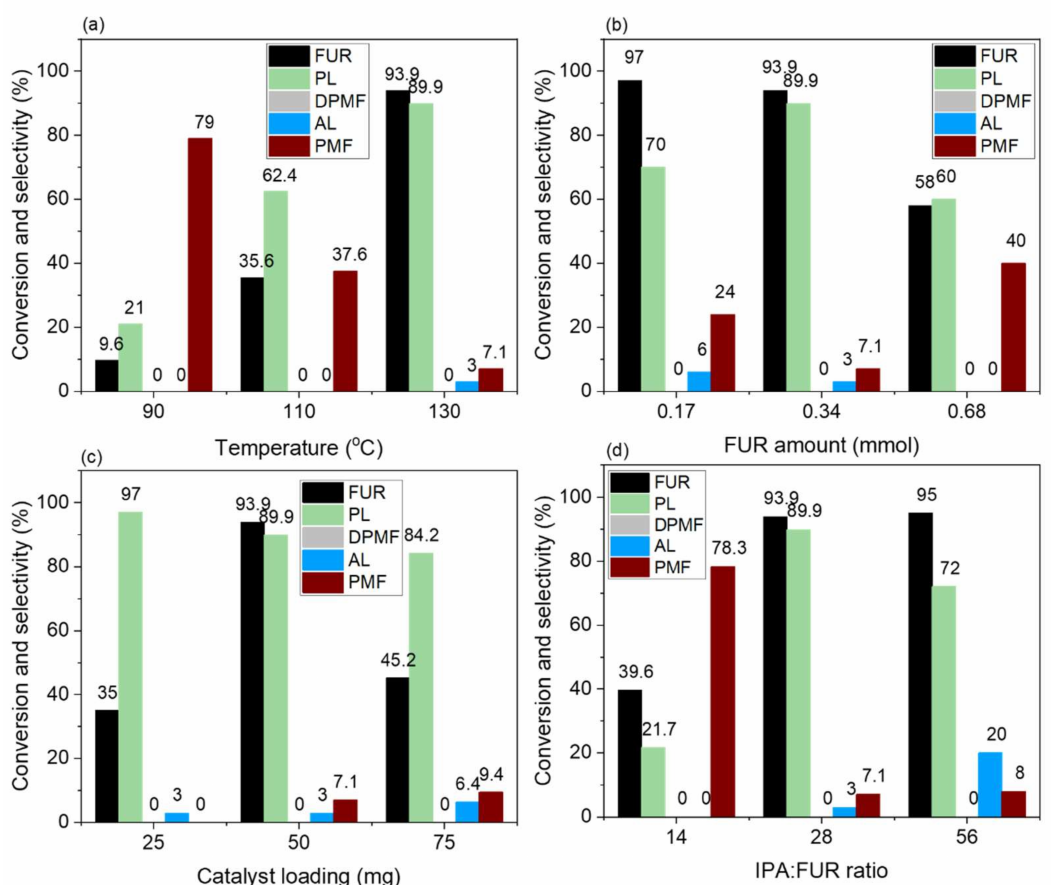
Figure 6. Catalytic evaluation of the reaction parameters for the alkaline-treated beta zeolite in the domino reaction of furfural upgrading. Reaction conditions: ( a ) 0.34 mmol of FUR, 50 mg of catalyst, 750 µ L of isopropanol, for 24 h; ( b ) 130 ◦ C, 50 mg of catalyst, 750 µ L of isopropanol, for 24 h; ( c ) 0.34 mmol of FUR, 130 ◦ C, 750 µ L of isopropanol, for 24 h; ( d ) 0.34 mmol of FUR, 130 ◦ C, 50 mg of catalyst, for 24